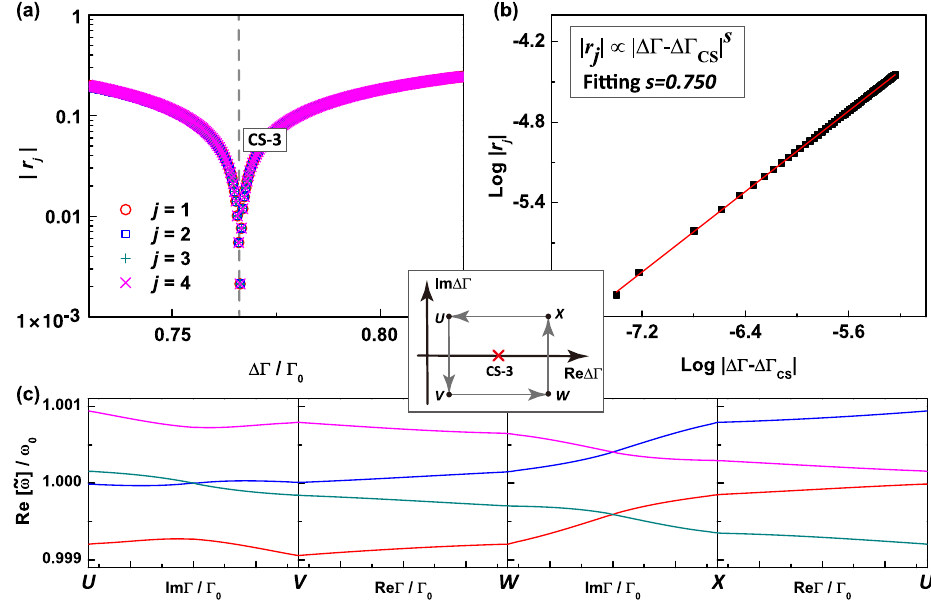
FIG. 7. (a) Phase rigidity of all the eigenstates as functions of asymmetric loss ΔΓ = Γ 0 for the point P 4 in the phase diagram shown in Fig. 2(b). (b) Log-log plot of phase rigidity j r j j versus j ΔΓ − ΔΓ for the CS-3 singularities (filled squares), and the fitting result is CS j shown by the solid line. The inset shows the looping path in the complex- ΔΓ plane, in which the CS-3 singularity locates inside the loop. (c) Eigenfrequency trajectories for looping around the CS-3 singularities in the counterclockwise direction ( U → V → W → X → U ) as shown in the